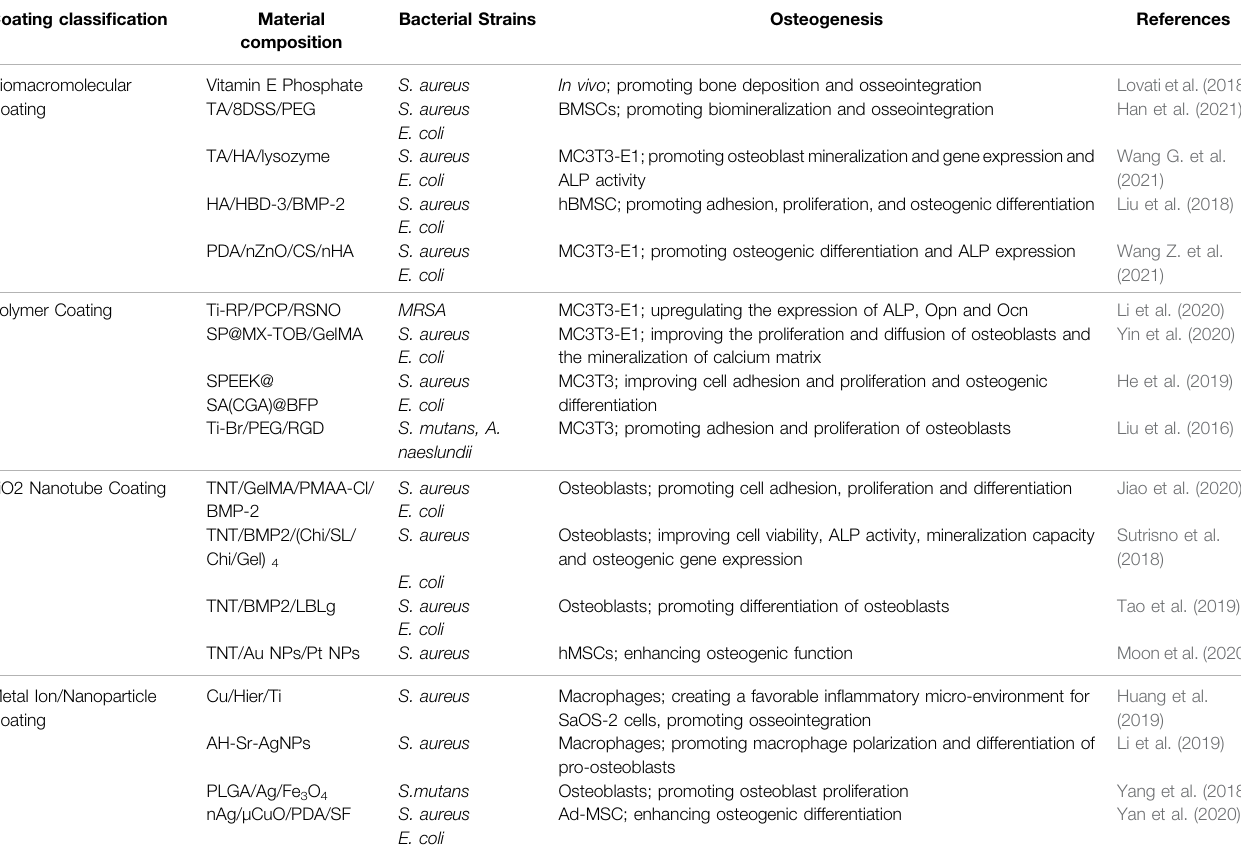
TABLE 1 | Antibacterial-osteogenic strategies of dental implant surface based on coating